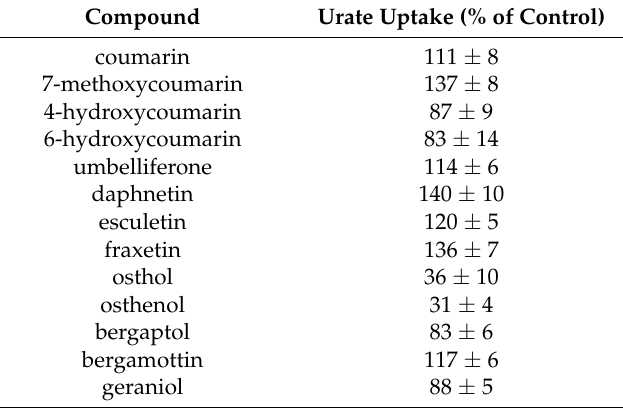
Table 1. Inhibitory effect of the related compounds of osthol on the uptake of urate via URAT1. Compound Urate Uptake (% of Control) coumarin 111 ±